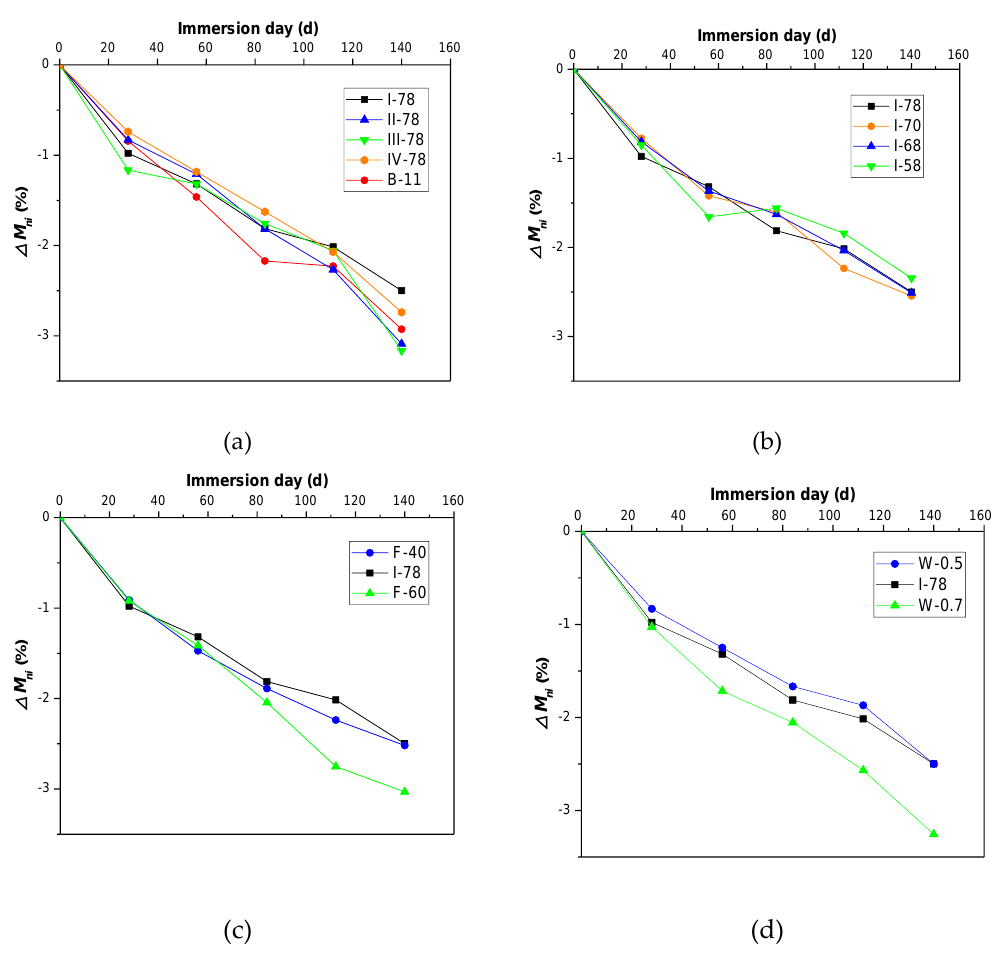
Figure 6. Mass loss rates of different FGM specimens in acid circumstance. ( a ) Coal gangue types and binder volume effect; ( b ) Aggregate gradation effect; ( c ) Fly ash proportion effect; ( d ) Water to binder ratio effect.